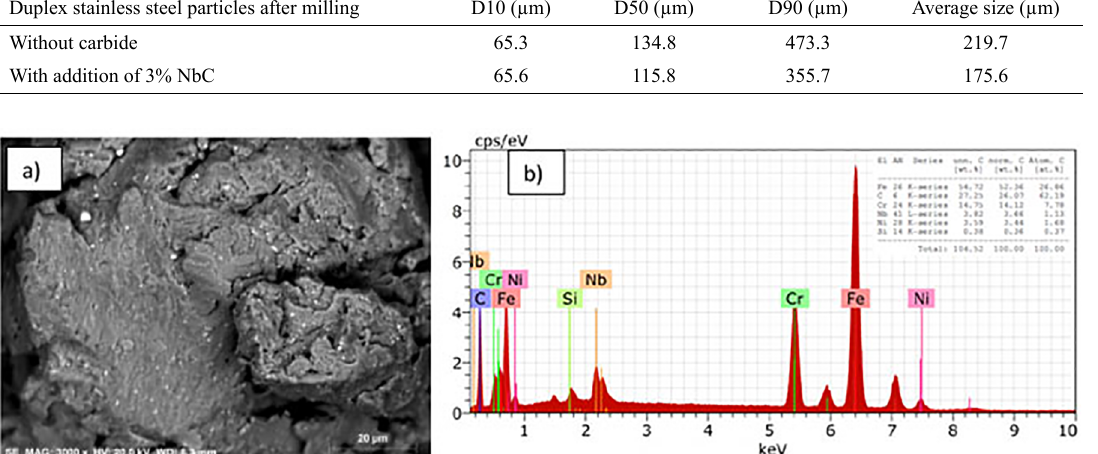
Figure 6. SEM image of the duplex stainless steel particles with NbC after 20 hours milling in the BSD mode (a); EDS analysis of duplex stainless steel for identifcation of main chemical elements (b).